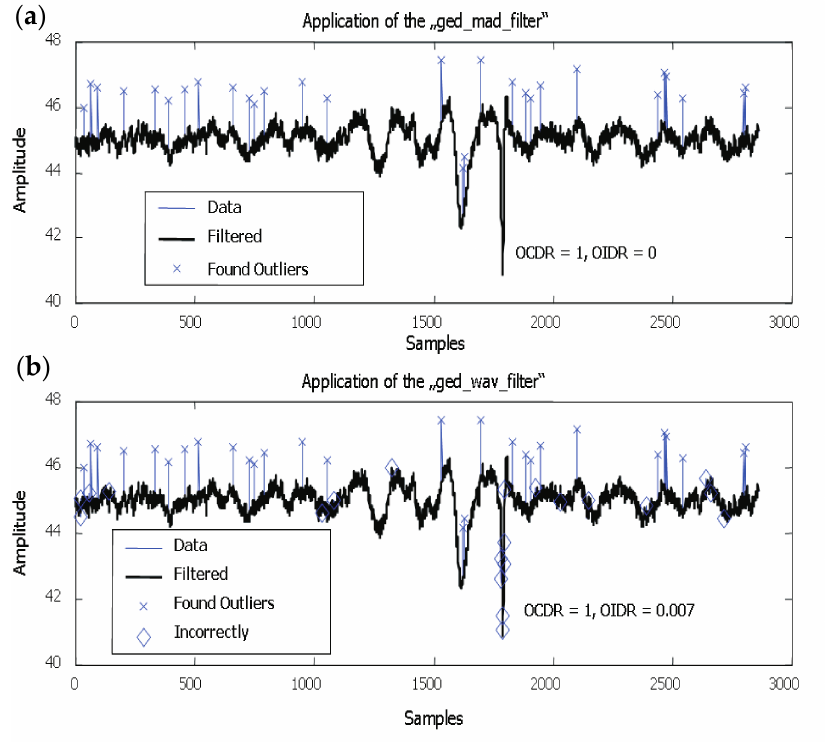
Figure 8. Comparison between ( a ) the presented algorithm in [10] and ( b ) that wavelet based on [5] proposed